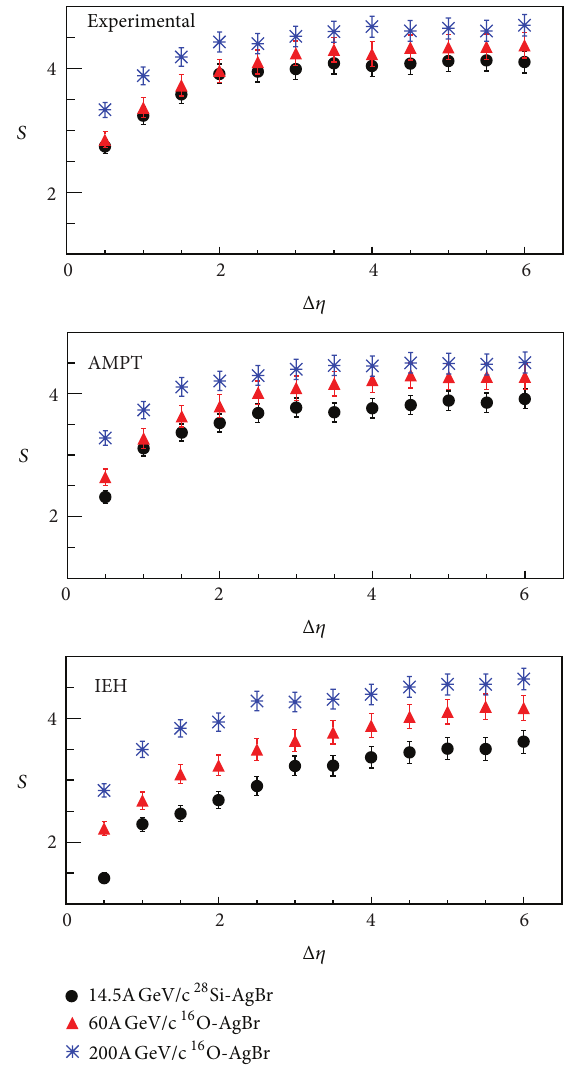
Figure 1: Variations of entropy with 𝜂 -bin width for the experimen- tal, AMPT, and IEH events at various